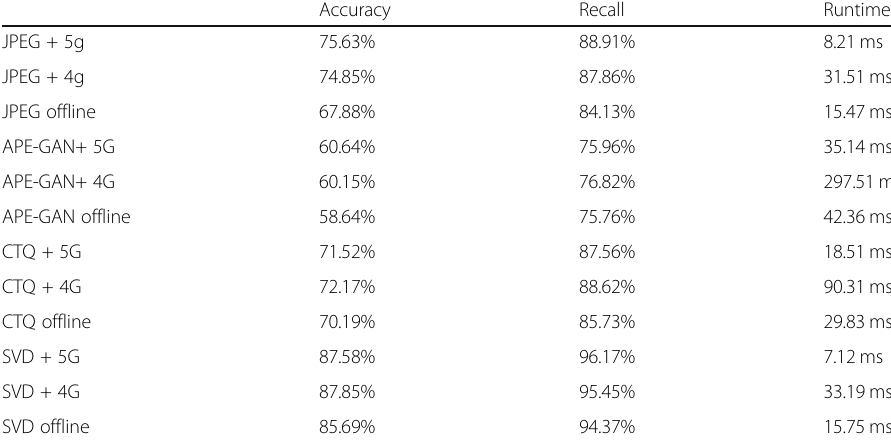
Table 4 The comparison result of the proposed method and other methods Accuracy